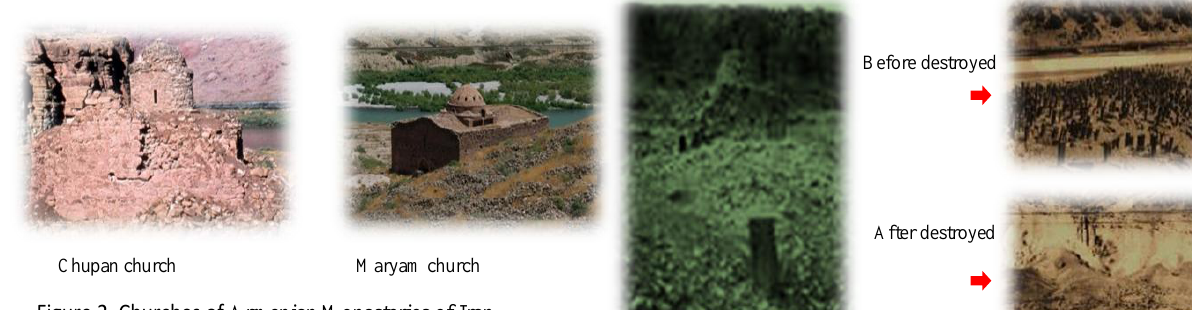
Figure 5. Cemetery of